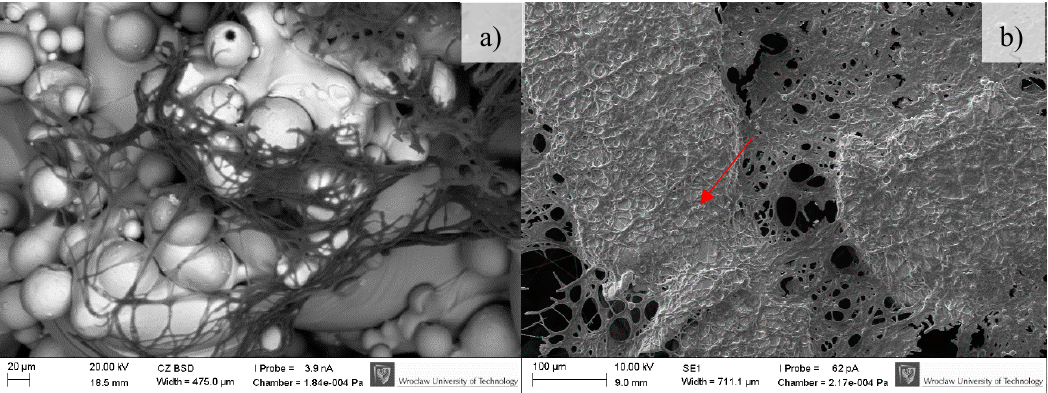
Figure 11. Osteoblasts after 30 days of incubation on tested implants. Samples not subjected (non-CP samples) ( a ) and subjected to chemical polishing (CP samples) ( b ). Red arrow indicate increasing amount of extracellular matrix embedding osteoblasts, SEM.